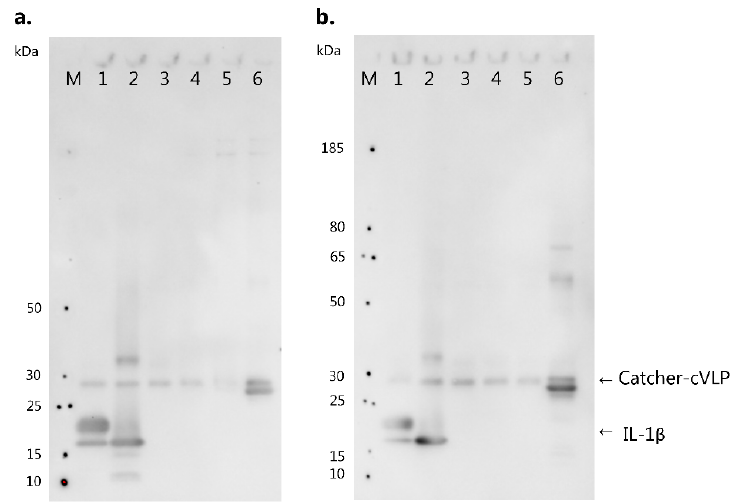
Figure 5. Vaccine ‐ induced antibodies show no cross ‐ reactivity with other IL ‐ 1 family